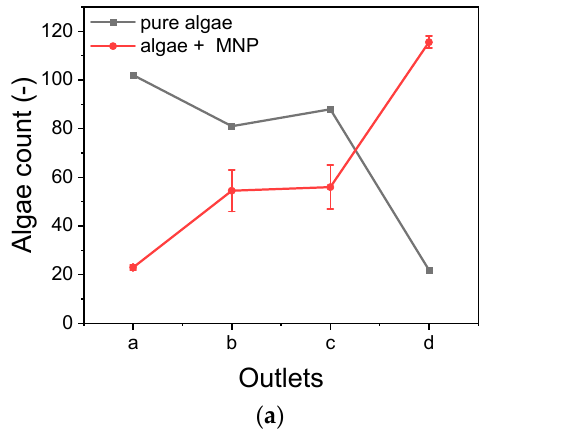
Figure 8. Separation process in millifluidic chamber 2. ( a ) Algae count from the Neubauer counting chamber for algae and mixtures of algae and magnetic nanoparticles. ( b ) Magnetic particle concen ‐ tration determined with phenanthroline assay for separation with and without (wo) magnet.